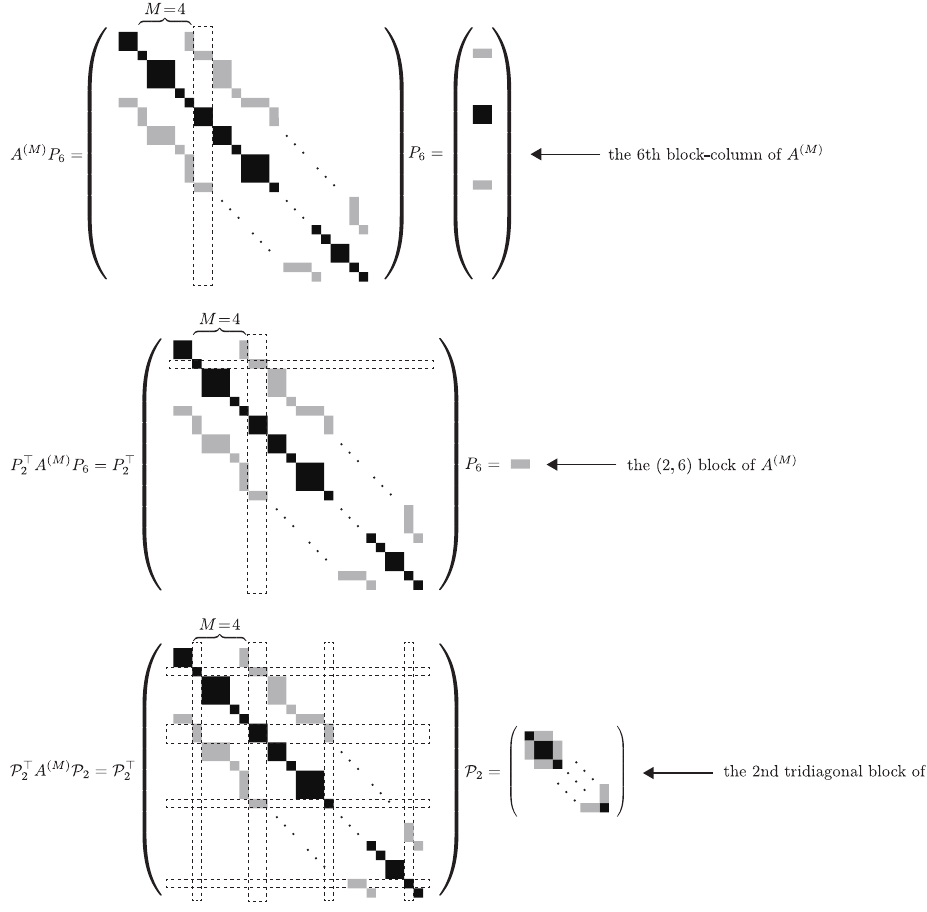
Figure 1. Gathering the block tridiagonal parts of the block M -tridiagonal matrix A ( M ) with M =